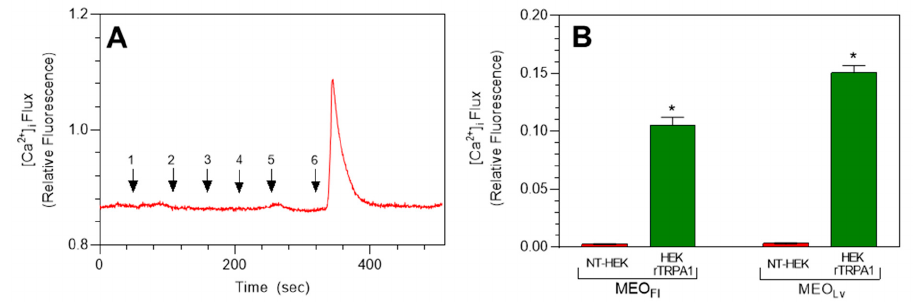
Figure 4. TRP agonist- and Monarda essential oil-induced increases in [Ca 2+ ] i are absent in parental HEK cells. Representative trace ( A ) showing the negligible effect in baseline [Ca 2+ ] i in parental HEK 293 cells treated consecutively with 100 µM of allyl isothiocyanate (AITC) (#1), 100 nM of capsaicin (#2), 10 µ M of GSK1016790A (#3), 20 µ g / mL of MEO Fl (#5), and 20 µ g / mL of MEO Lv (#6). Receptor-effector coupling was confirmed by treating the cells with 25 µM of ATP (#6). Summarized data comparing the effects of MEO Fl and MEO Lv on [Ca 2+ ] i in parental HEK 293 and HEK rTRPA1 cells ( B ). The data are expressed as change in the [Ca 2+ ] i influx from baseline to peak [Ca 2+ ] i and plotted as the mean ± SEM. * p < 0.0001 compared to agonist-induced [Ca 2+ ] i influx. Statistical analysis was performed using two-way analysis of variance; n = 90 cells from 3 independent experiments.